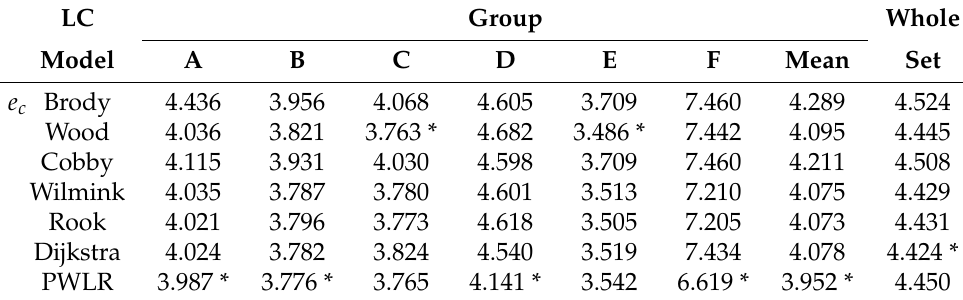
Table 5. Cross-fitting errors of k -fold cross-validation. LC Group Whole Model A B C D E F Mean